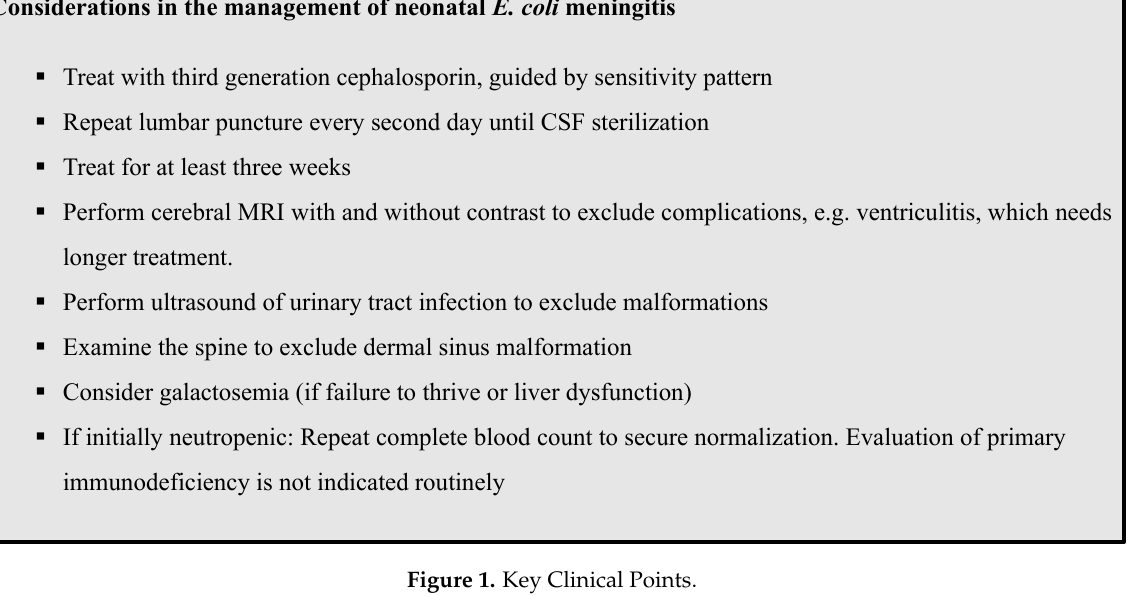
Figure 1. Key Clinical Points.